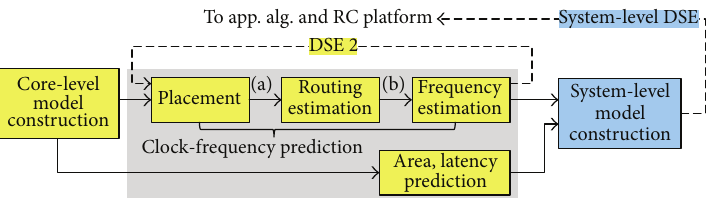
Figure 5: CMD parameter prediction with (a) placed core-level model and (b) estimated routing